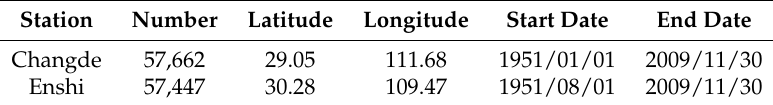
Table 1. Description of the rainfall data.